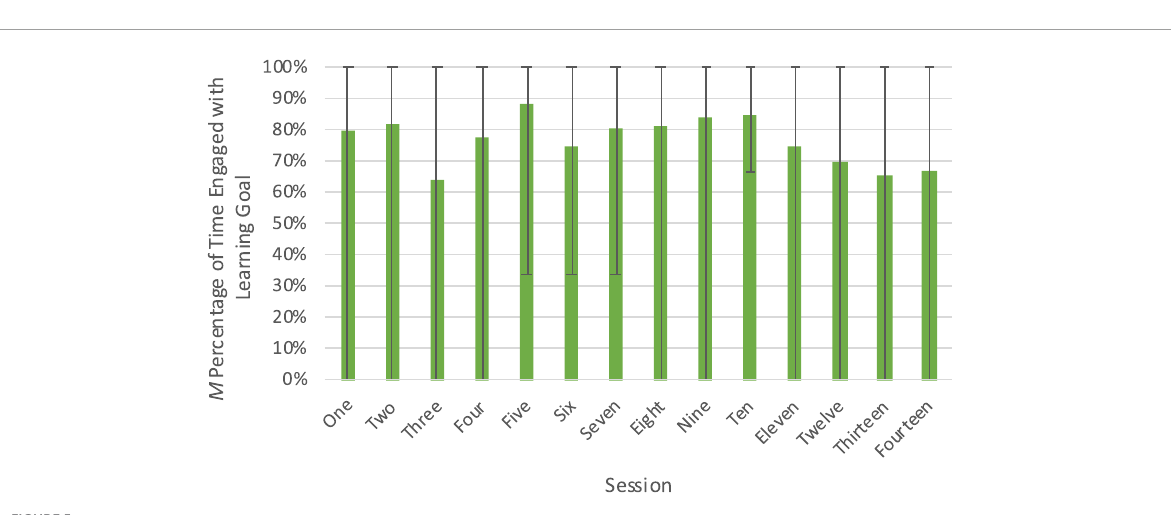
FIGURE5 Engagement with learning goals across sessions of the Block Play Intervention. Figure shows percentage of engagement out of total coded time (three time intervals) with the learning goal at each session. The range from minimum to maximum engagement is represented by error